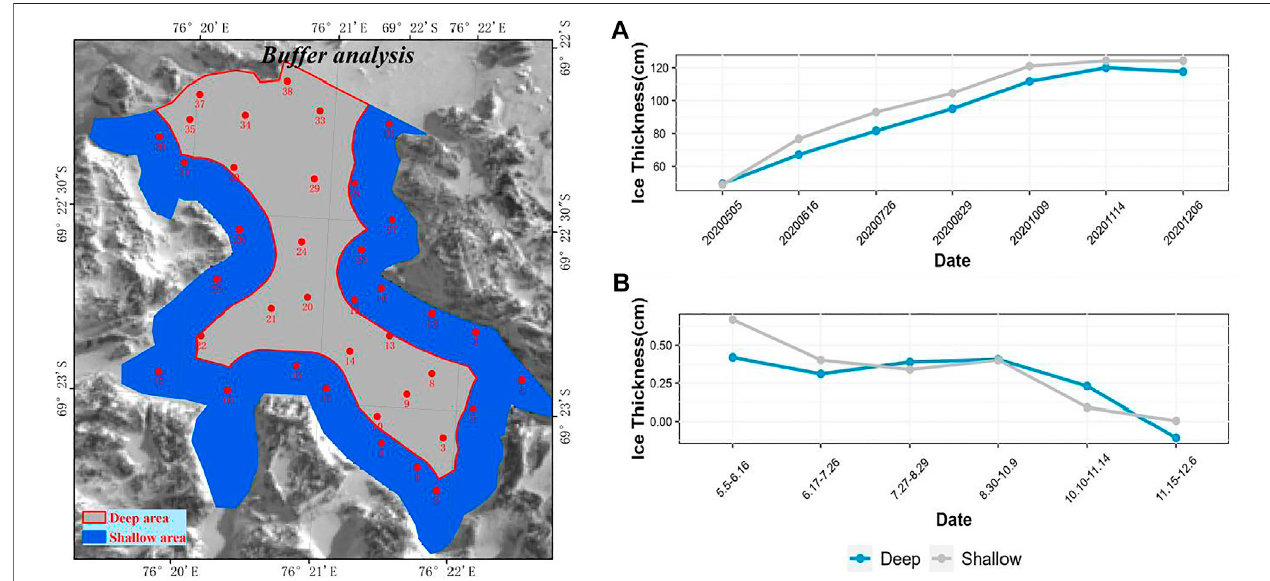
FIGURE 5 | Buffer analysis. [ (A) : Sea ice thickness in deep water and shallow water areas in 7 periods; (B) : Sea ice growth rate in deep water and shallow water areas in 7 periods].